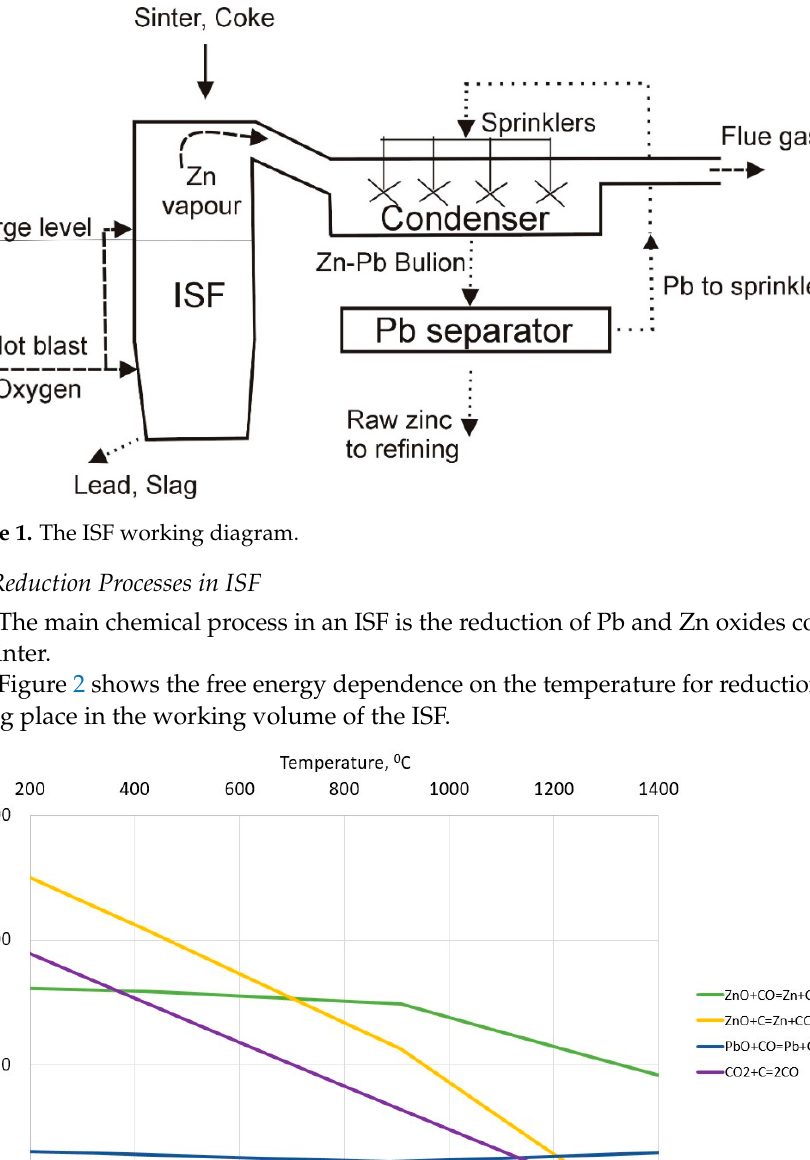
Figure 1. The ISF working diagram.